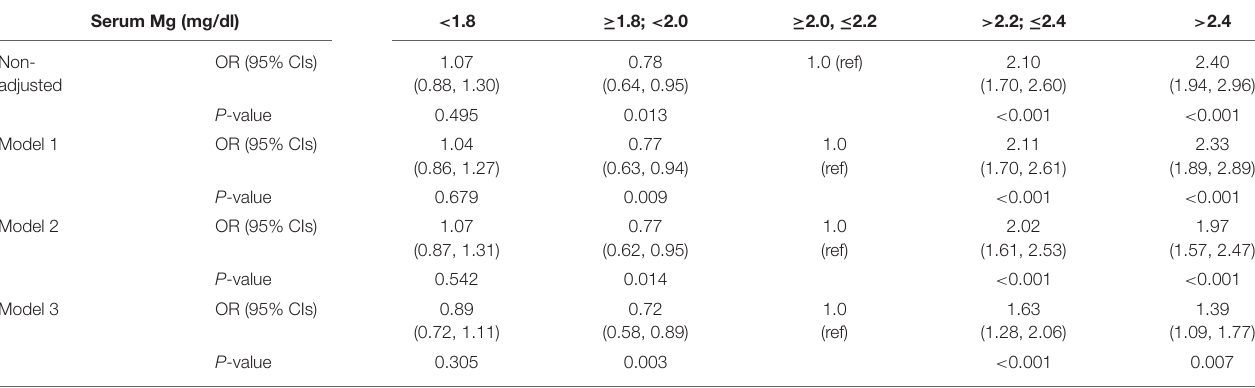
TABLE 2 | ORs (95% CIs) for mortality across groups of serum magnesium. Serum Mg (mg/dl) < 1.8